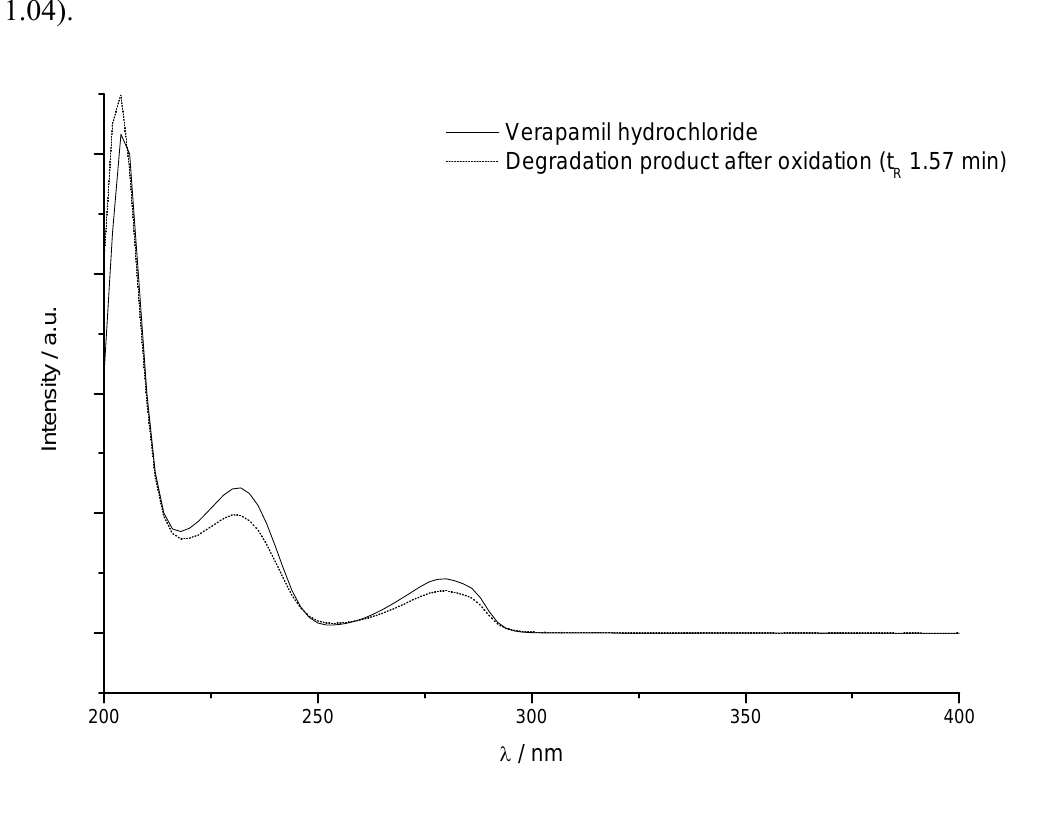
2.09, k’ 1.72) before ( ___ ) R 1.570, R